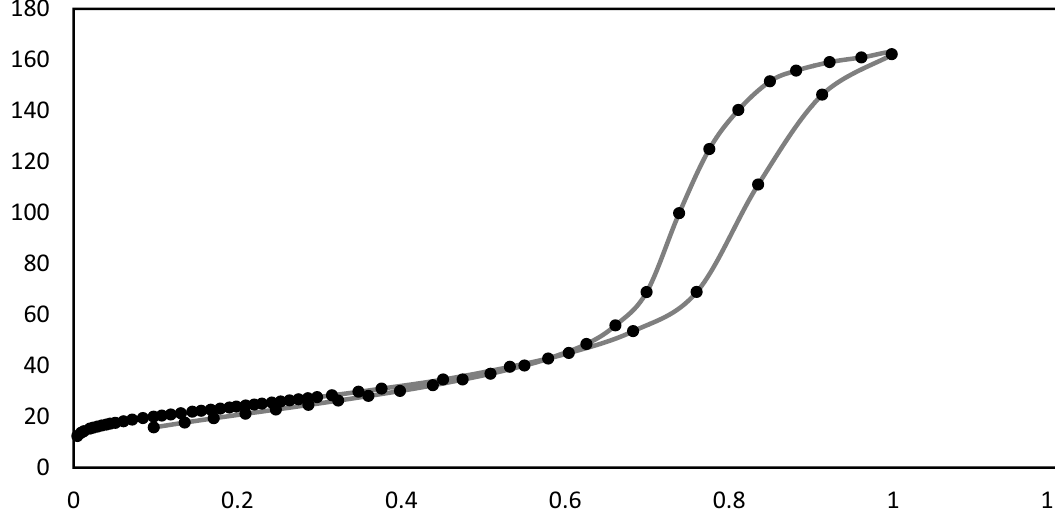
Figure 6. N 2 Adsorption Desorption Isotherm of Nano CoAl 2 O 4 Catalyst.